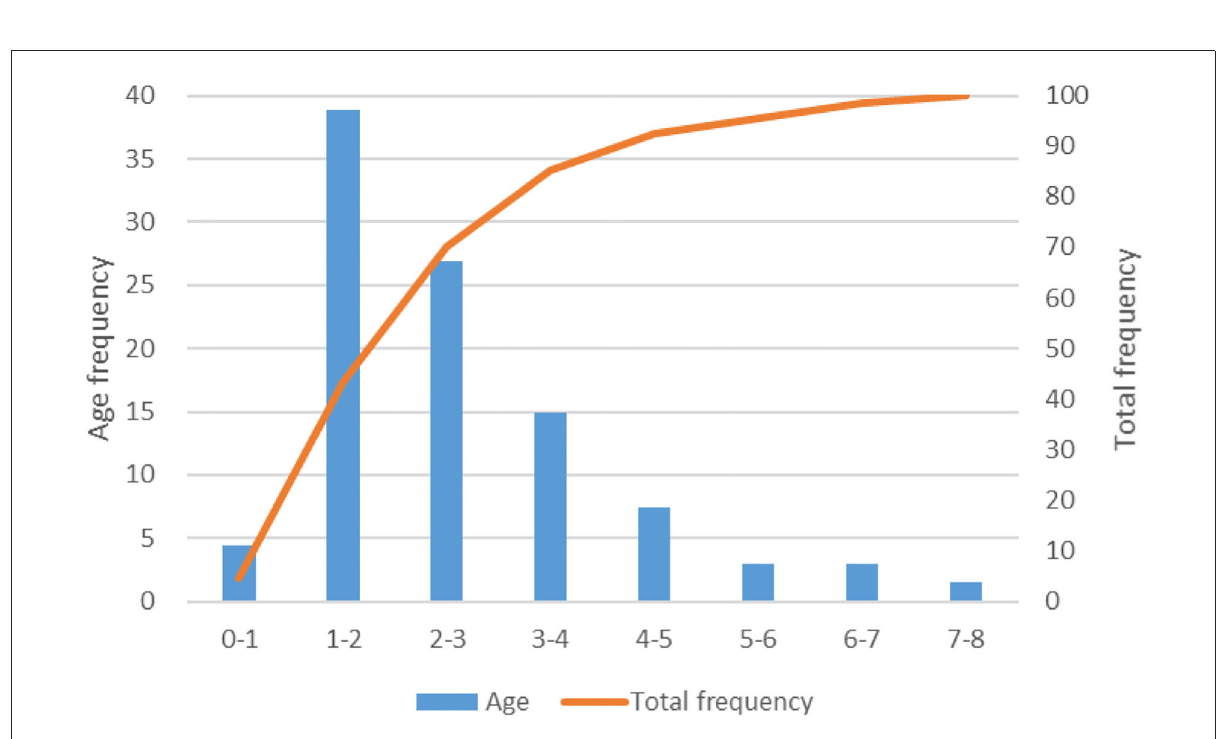
FIGURE8 Frequency of estimated age classes of archeological Chinese sea